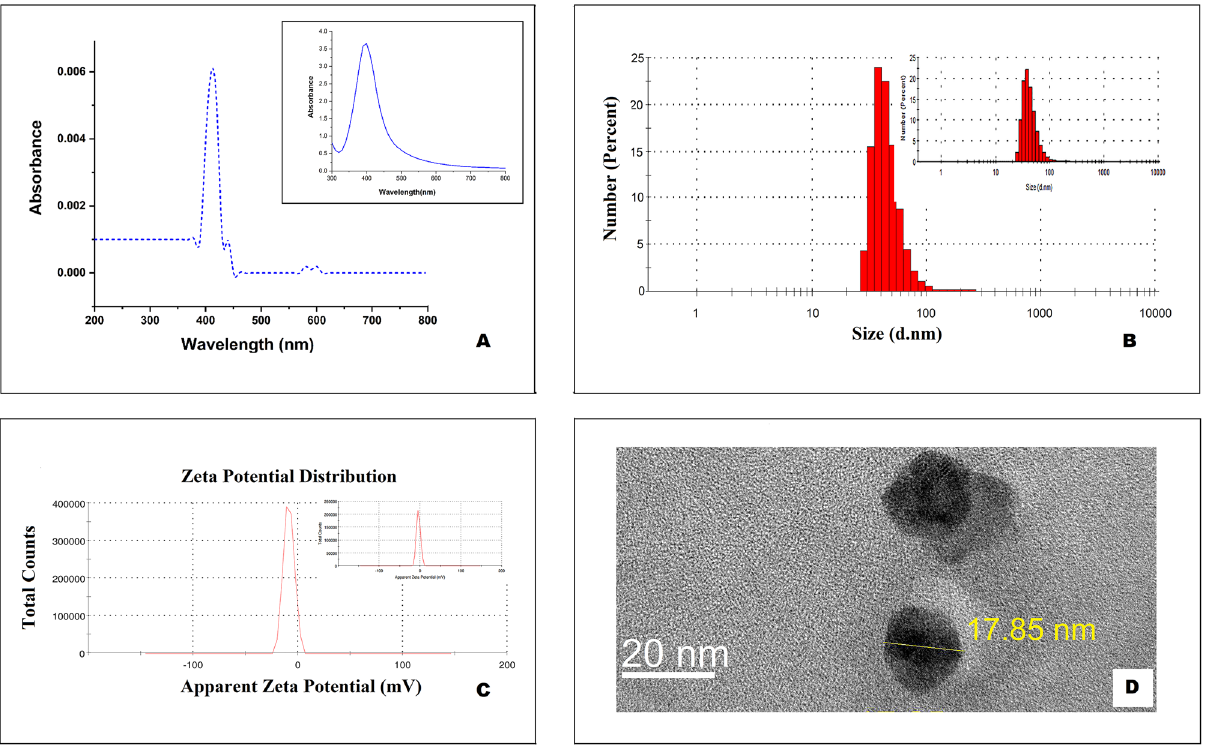
Figure 1. Physical characterization of AgNP-Serum-18. ( A ) UV–Vis absorption spectra of AgNP-Serum-18 from 200–800 nm; inset: high concentration (tenfold). ( B ) Cluster size obtained from DLS measurements of freshly prepared samples; inset: after 2 month. ( C ) Zeta potential of AgNP-Serum-18 of freshly prepared samples; inset: after 2 month. ( D ) TEM